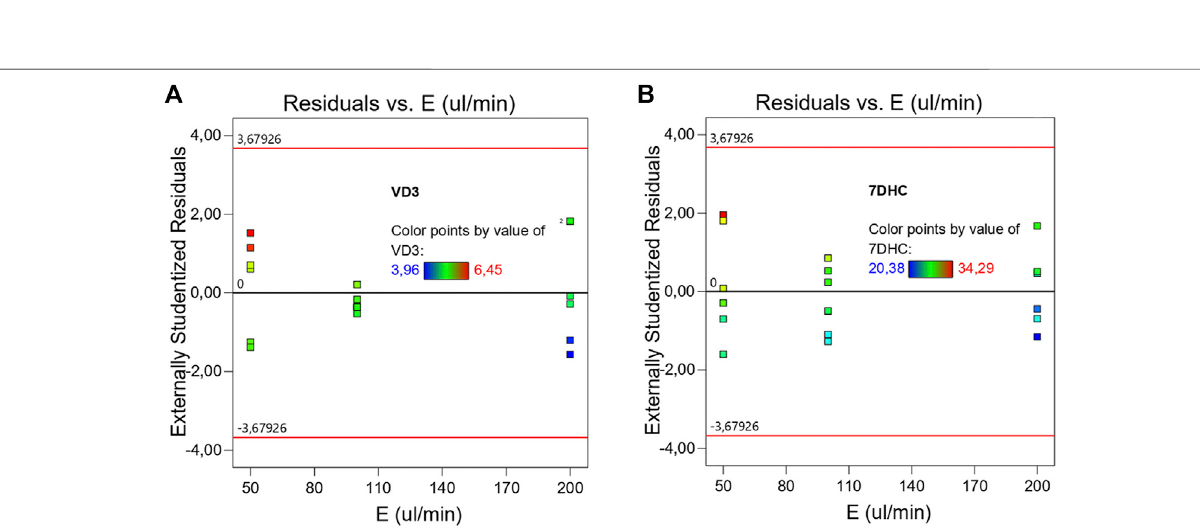
Frontiers in Chemical Engineering |